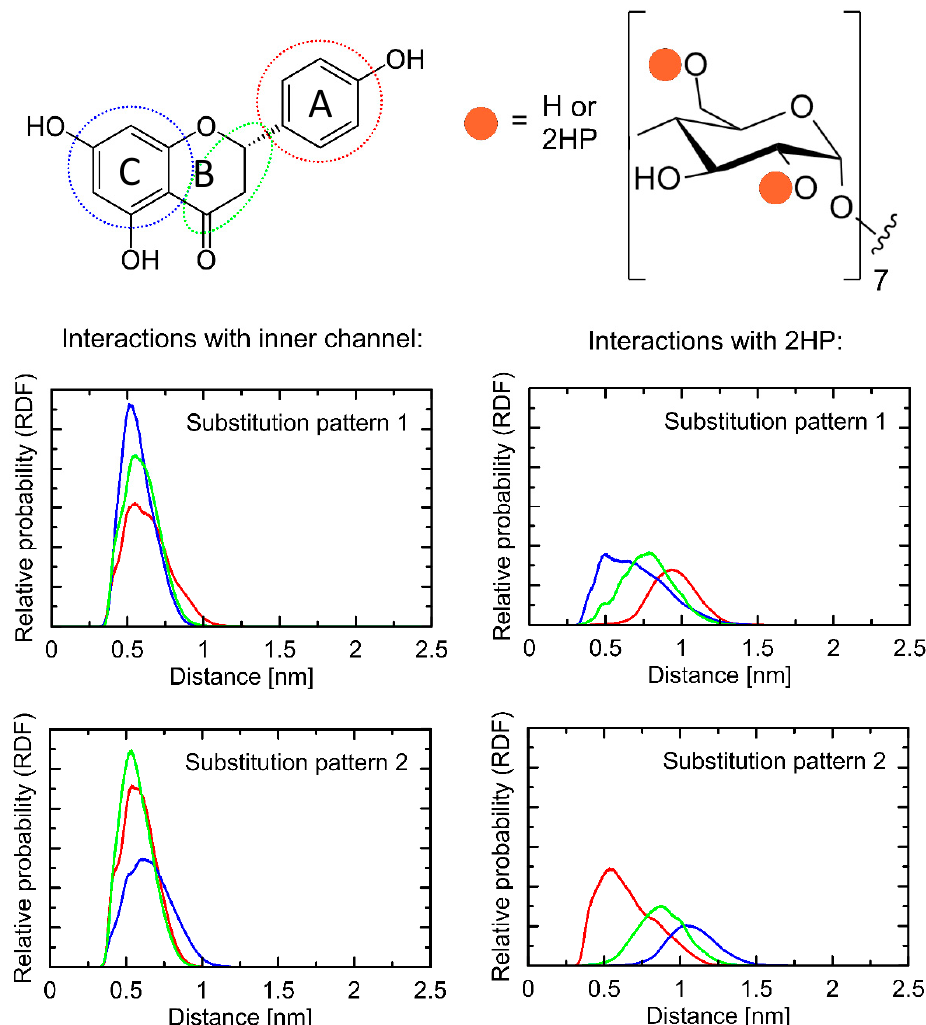
Figure 8. RDFs calculated for the distances between selected fragments of the studied systems. In the case of HP- β -CD, both the inner channel (aliphatic carbon atoms within carbohydrate rings) and 2HP moieties were distinguished, whereas the molecule of NAR was considered as the three separate groups. The color code is maintained throughout the figure.